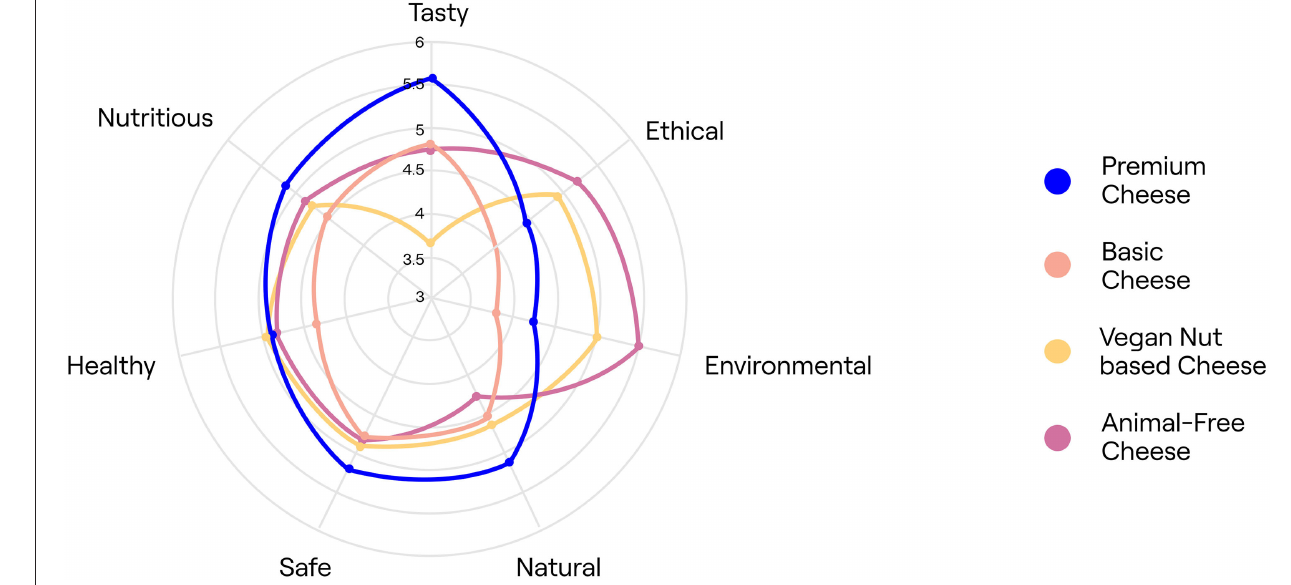
FIGURE 5 | Average perceptions of different cheese products from across countries.